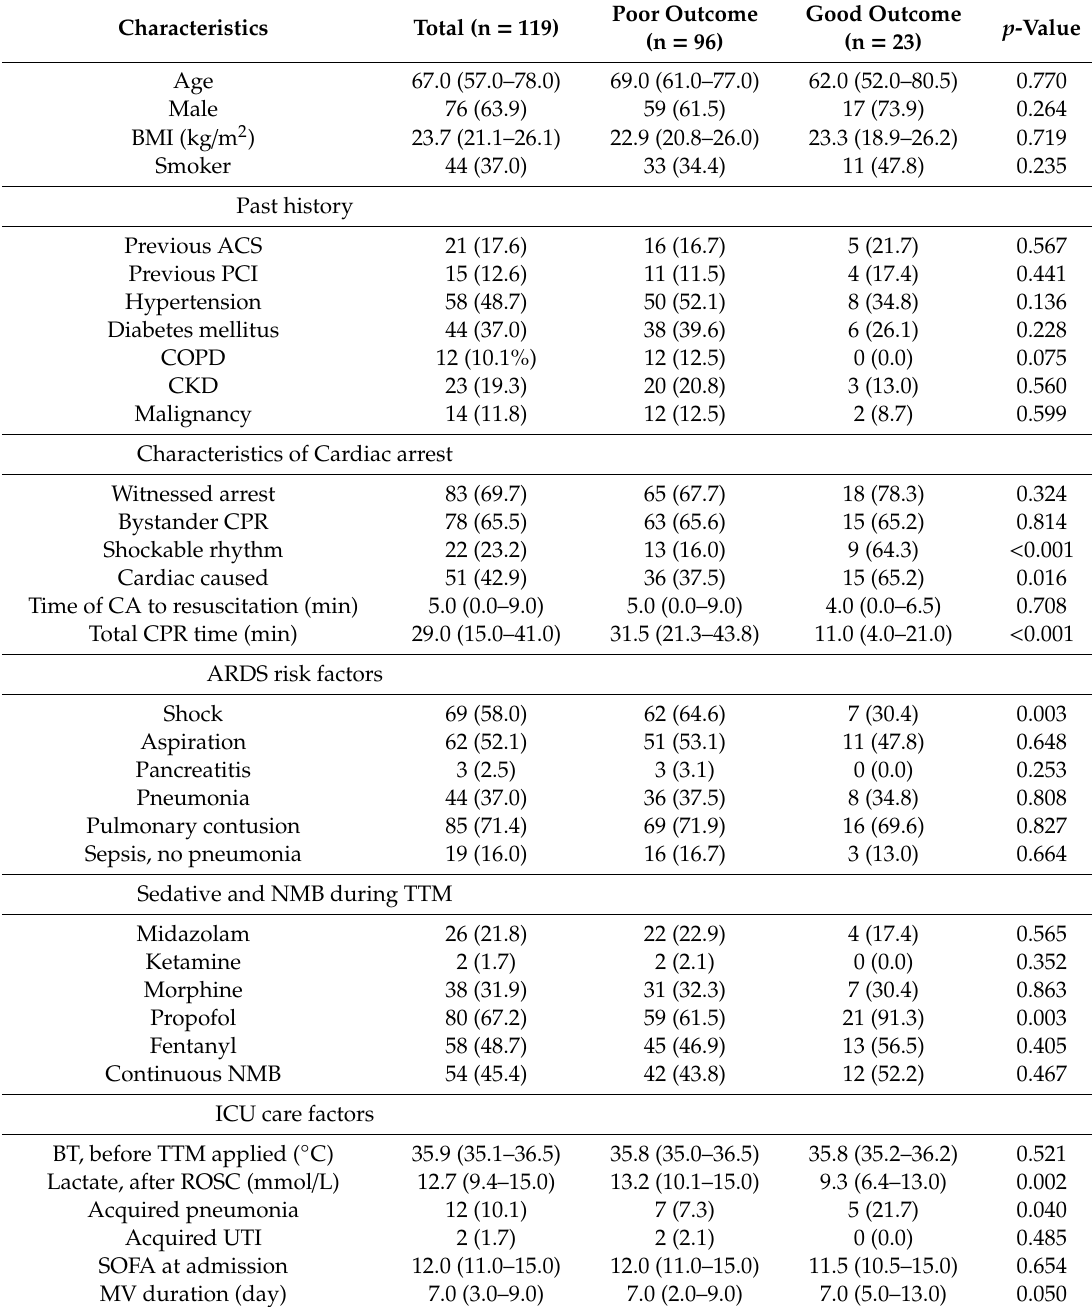
Table 1. Baseline characteristics of the ARDS